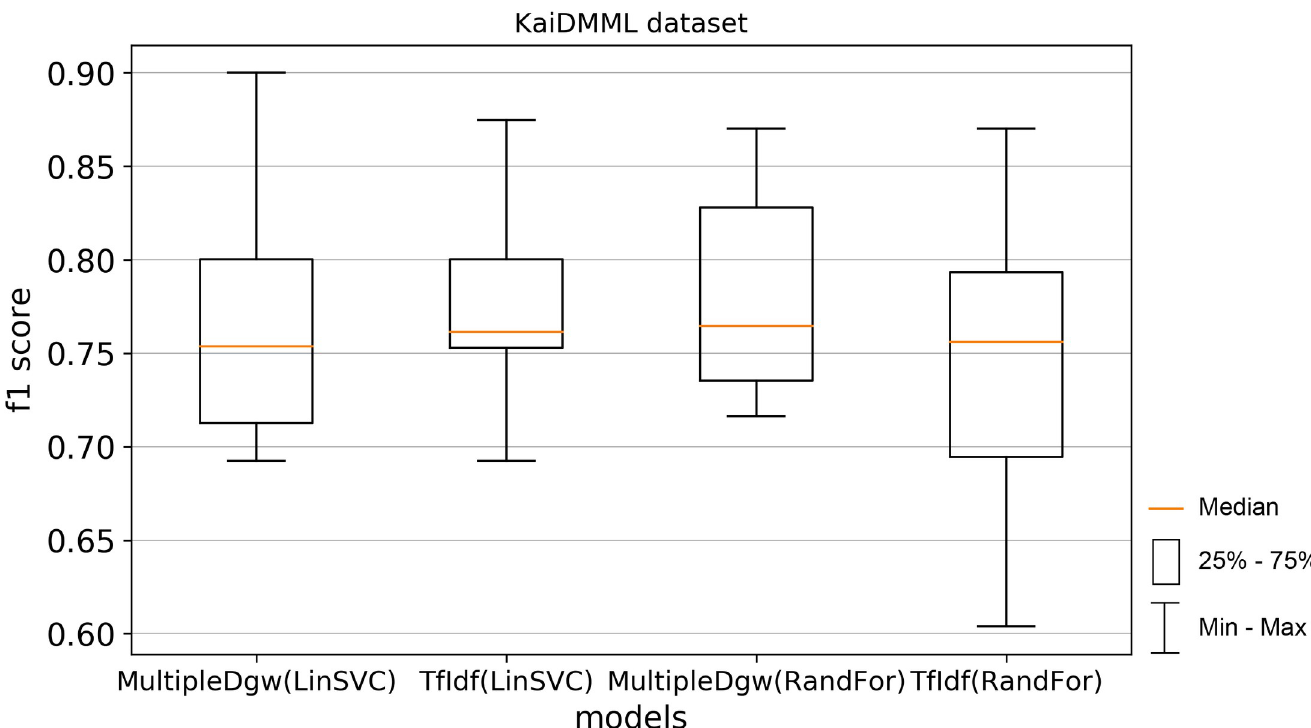
Fig 13. Boxplot for the model performance measurement - f1-score for dataset KaiDMML.